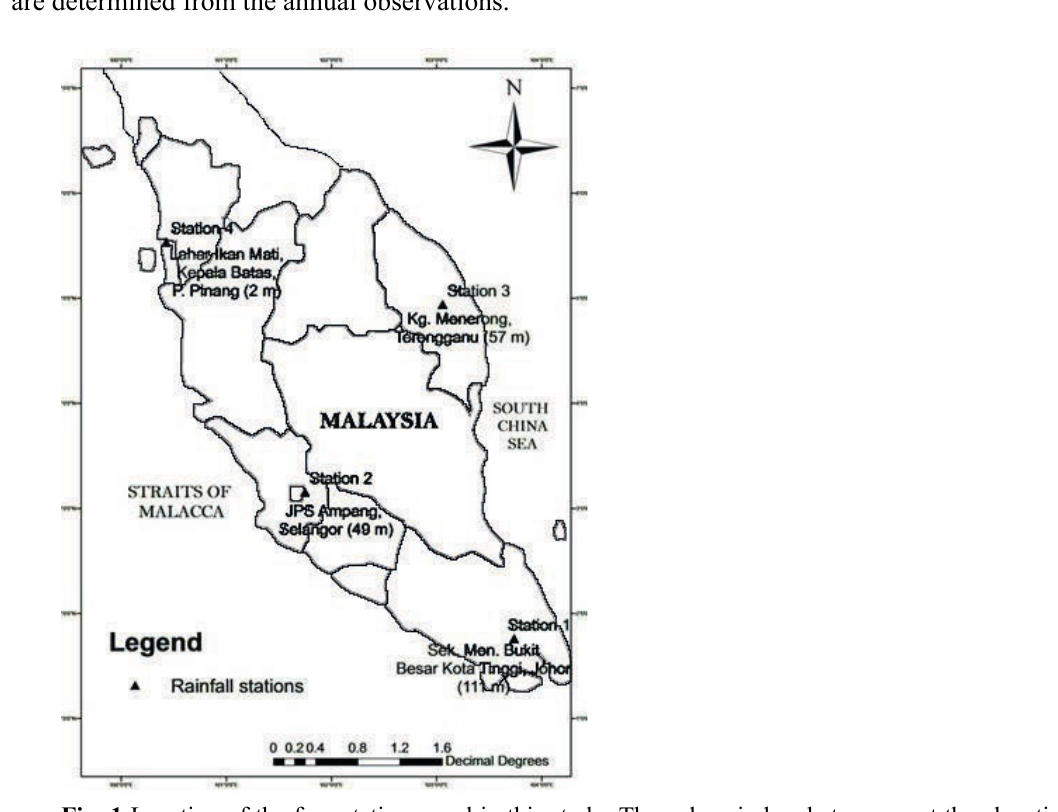
Fig. 1 Location of the four stations used in this study. The values in bracket represent the elevation of the station. Factor of